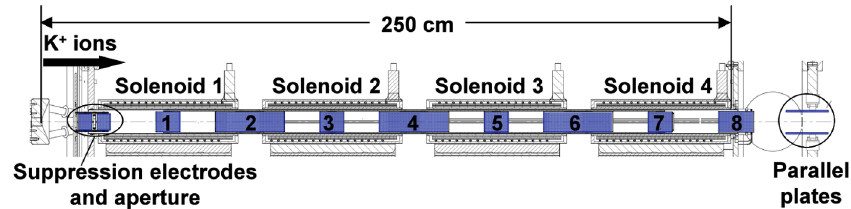
FIG. 6. (Color) Layout of the aperture and suppression electrodes, electron cloud diagnostics: solenoid electrodes (1, 3, 5, and 7), gap electrodes (2, 4, 6, and 8); and parallel plate diagnostic relative to the four-solenoid lattice. All the diagnostics have cylindrical symmetry except for the parallel plate diagnostic.